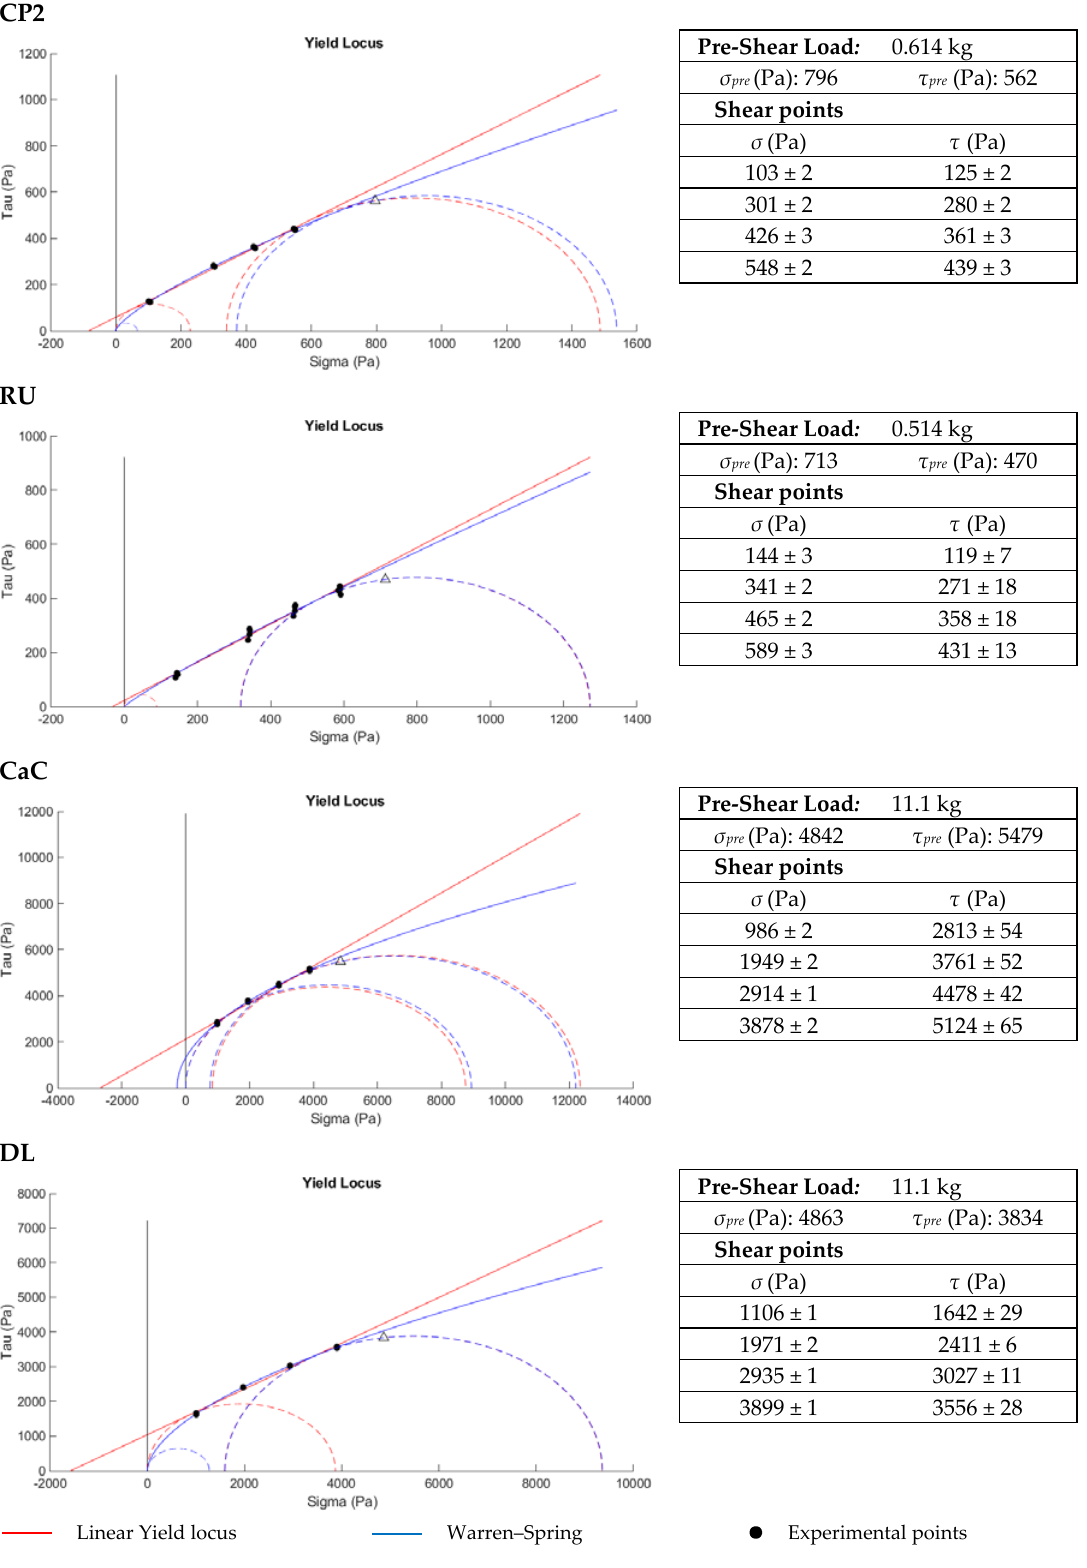
Figure 8. Yield locus plots and experimental data for four samples.